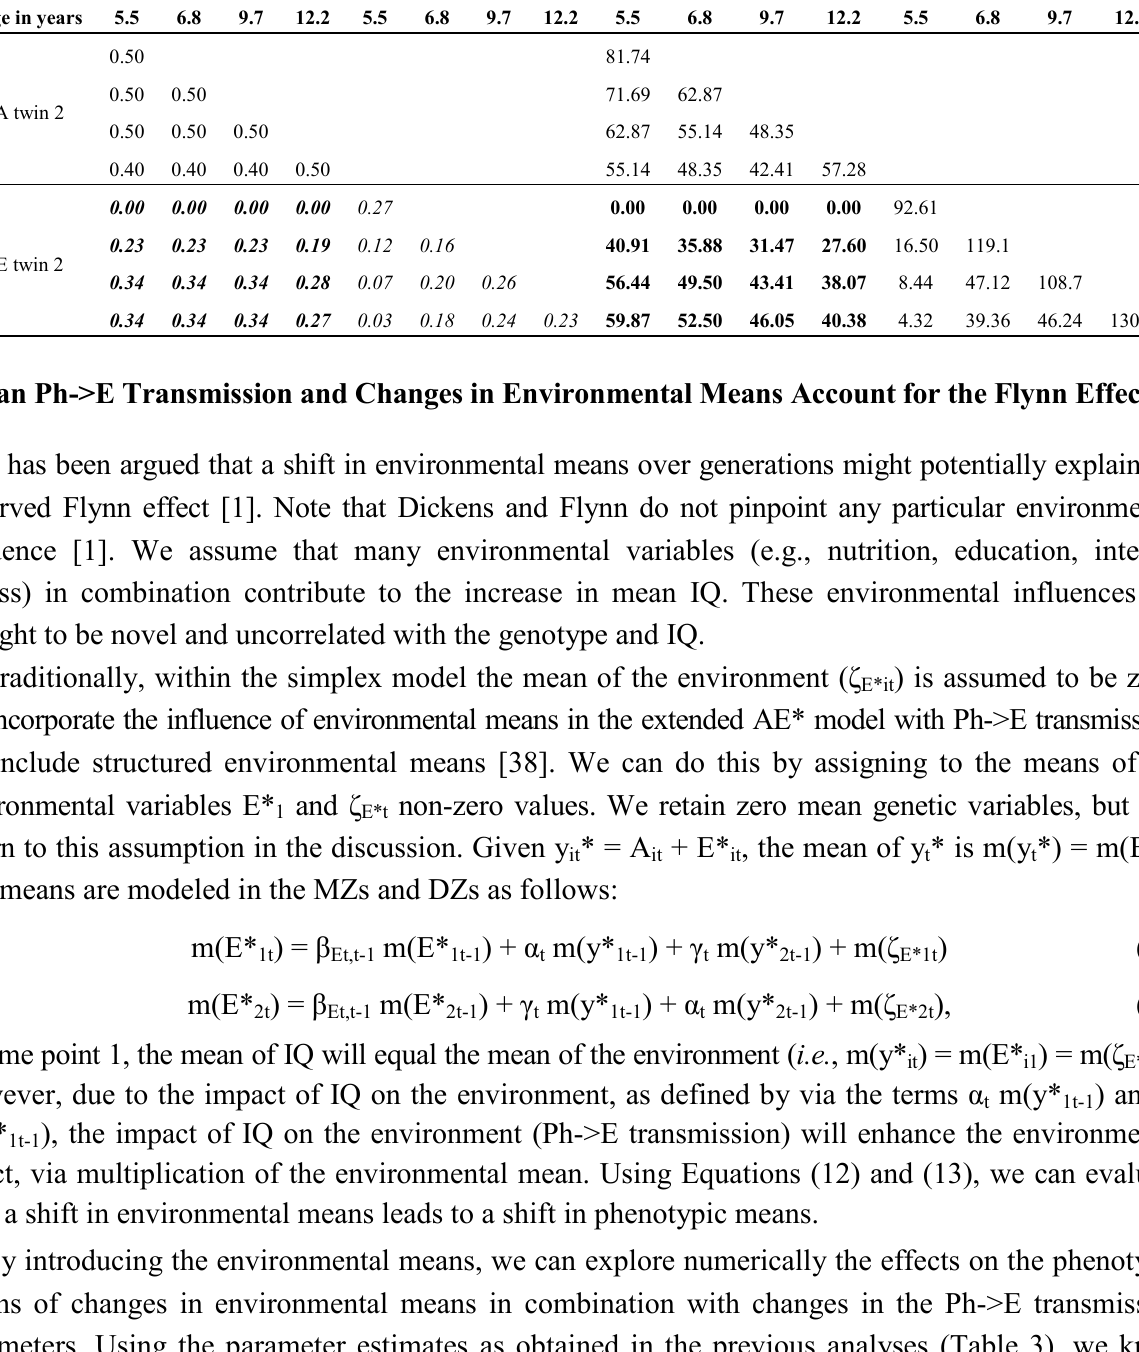
Table 5. Cont. Correlation Covariance A Twin 1 E* Twin